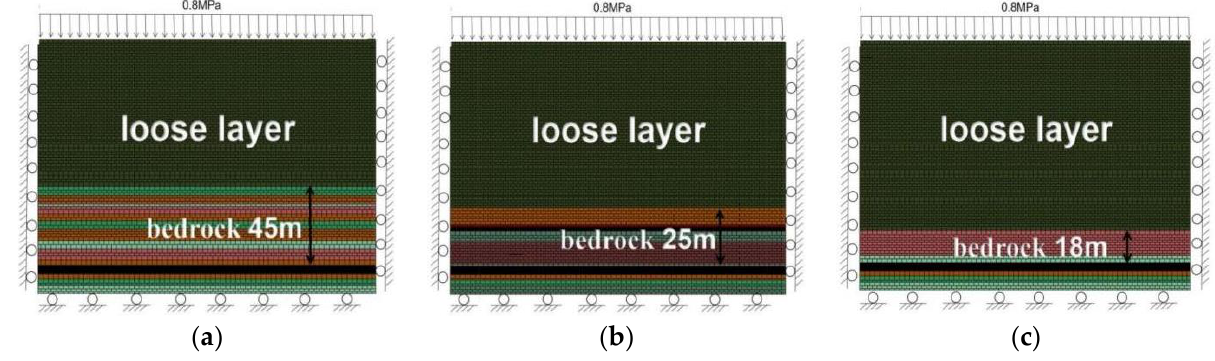
Figure 7. Two dimensional UDEC model of regions 1, 2, and 3. ( a ) Thickbedrock region. ( b ) Thin bedrock region. ( c ) Insufficient bedrock region. Table 2. Numerical model parameters.